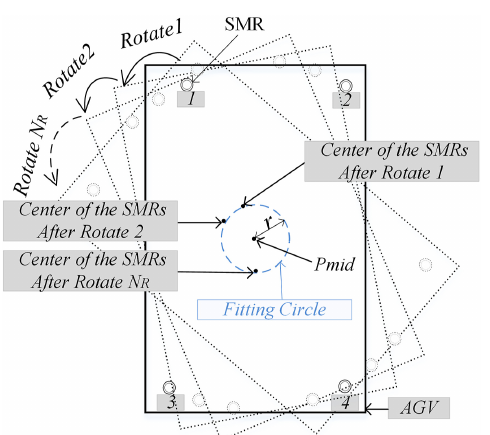
Figure 1. The proposed navigation system consists of map construction and navigation method and map construction is the prearrangement for navigation method